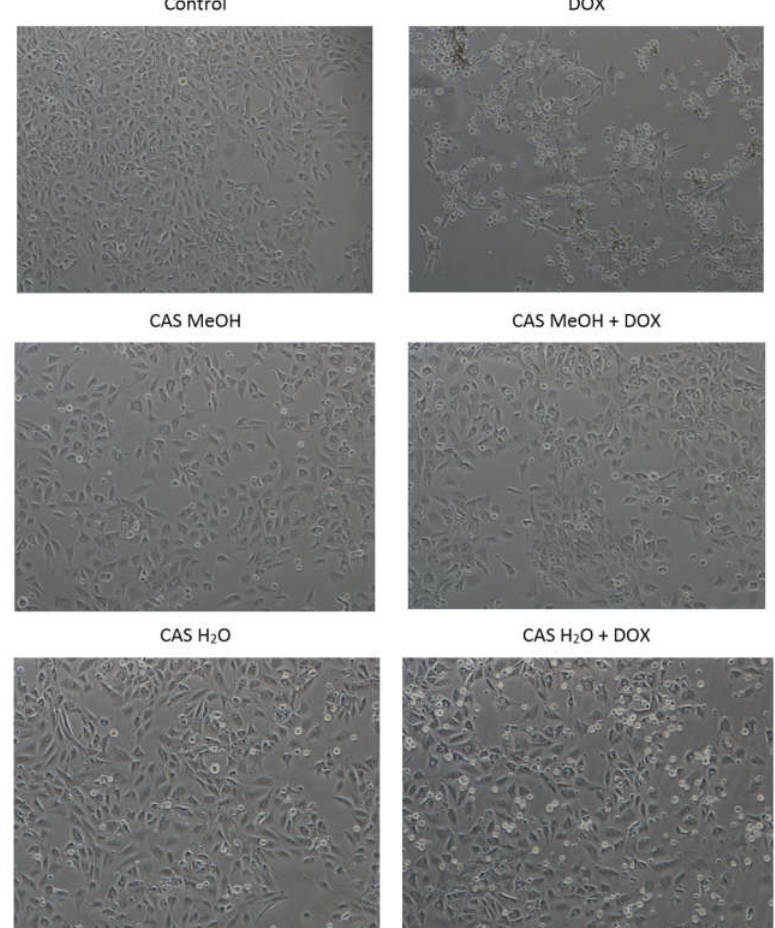
Figure 2. Morphological changes in H9c2 cells. Cells were treated for 48 h with 2 µM of DOX and 125 µg/mL of CAS H 2 O or 125 µg/mL of CAS MeOH, or a combination (DOX + CAS MeOH/DOX + CAS H 2 O) (magnification: ×100). DOX: doxorubicin; CAS MeOH: Centaurea castriferrei Borbás & Waisb methanol–water (7:3 v/v ) extract; CAS H 2 O: Centaurea castriferrei Borbás & Waisb water ex-